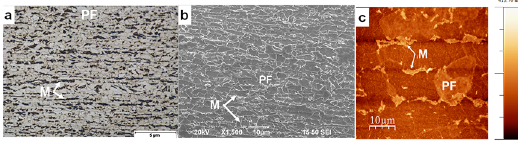
Figure 1. Micrographs of the AHSS DP600 in the BM: a) OM, b) SEM and c) AFM. Etchant: Nital.